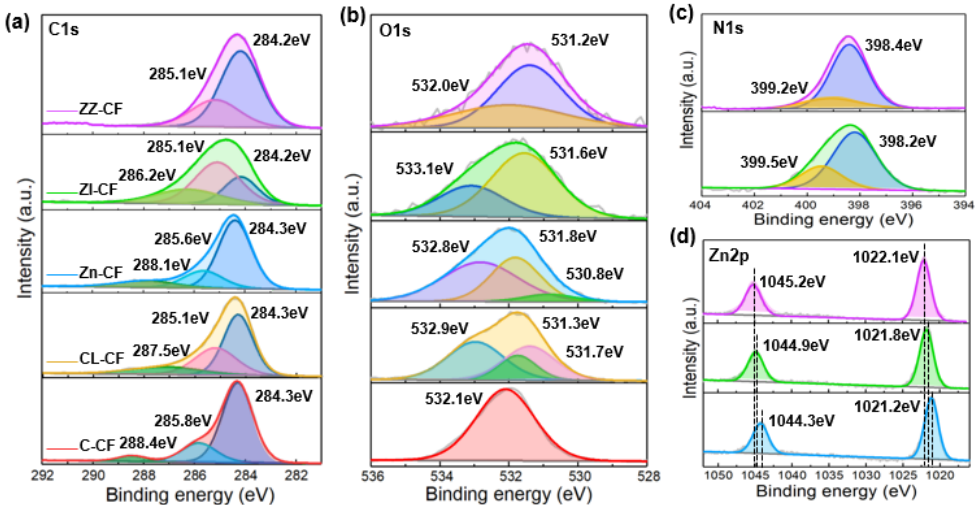
Figure 2. XPS spectra of ( a ) C 1s, ( b ) O 1s for C–CF, GL–CF, Zn–CF, ZI–CF, and ZZ–CF; ( c ) N 1s,